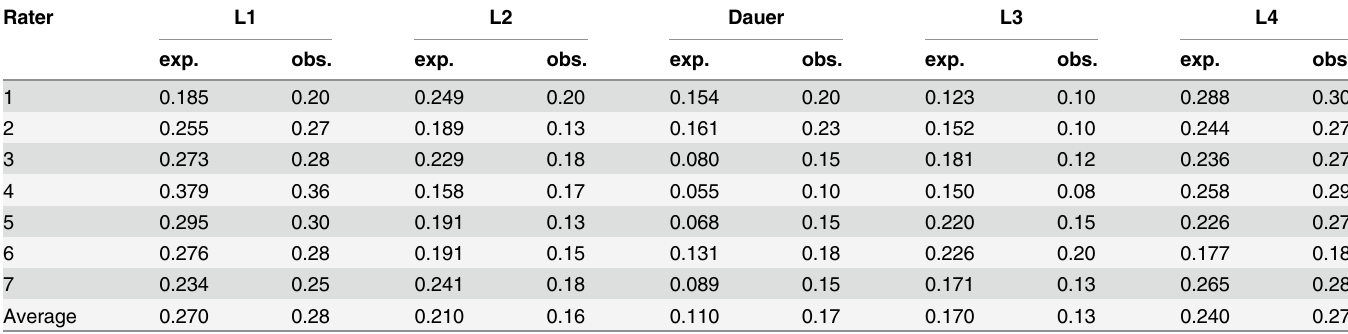
Table 2. Expected proportions of larval stages for each rater based on model, and observed proportions.